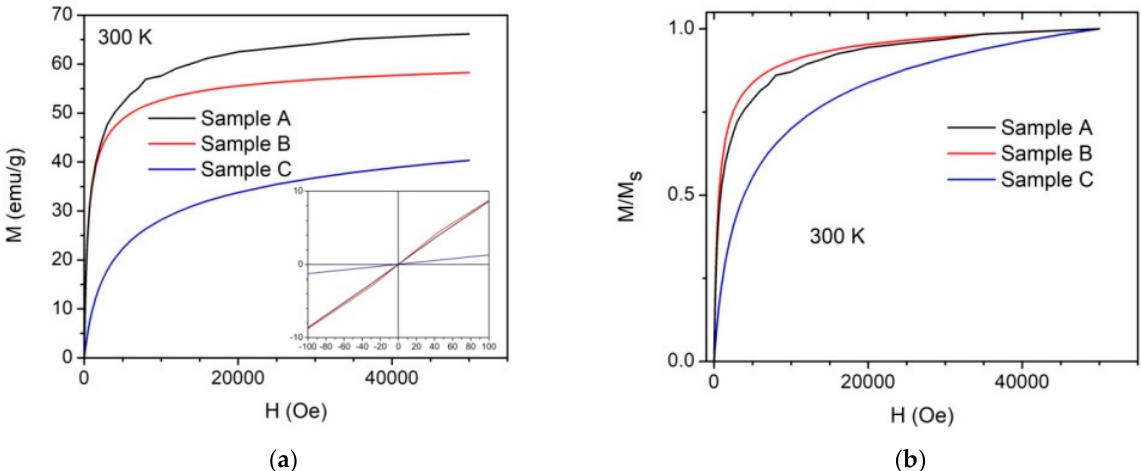
Figure 4. Magnetization (emu/g) vs. magnetic field intensity (Oe) curves of samples A,B and C measured at RT. The inset in the low right part of the figure shows that the NPs do not have a remanence at 300 K ( a ); Curves of the magnetization vs. magnetic field intensity normalized to their respective maxima of samples A, B and C measured at RT ( b ).